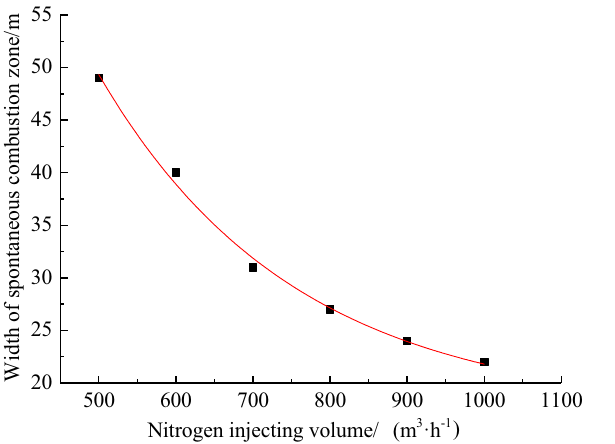
Figure 8. Fitting curve between nitrogen injection volume and width of spontaneous combustion